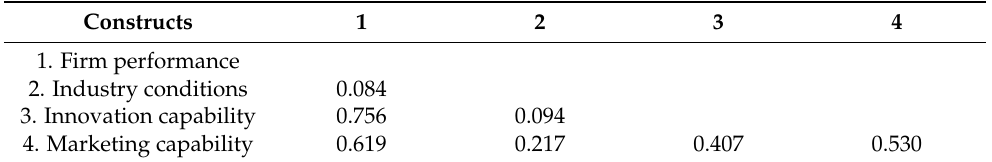
Figure 2. Results from confirmatory factor analysis showing indicator loadings. Table 2. Heterotrait–monotrait ratio